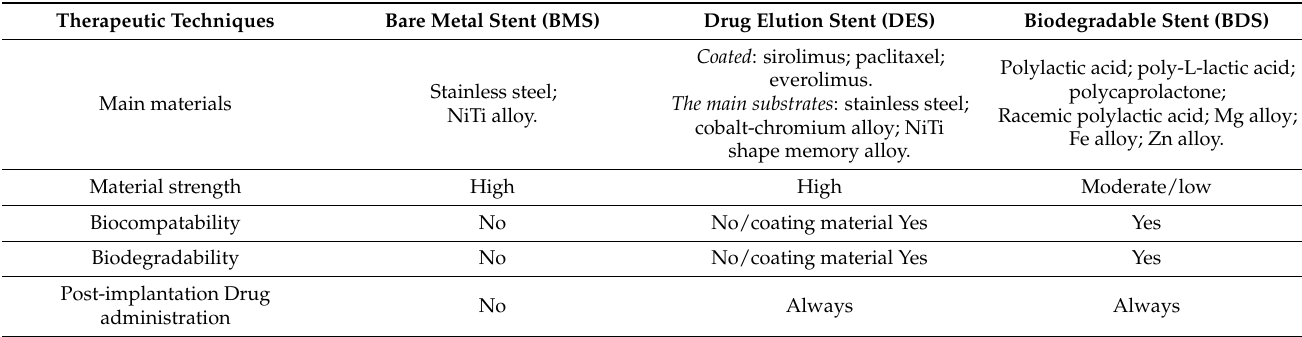
Table 1. Materials and properties of